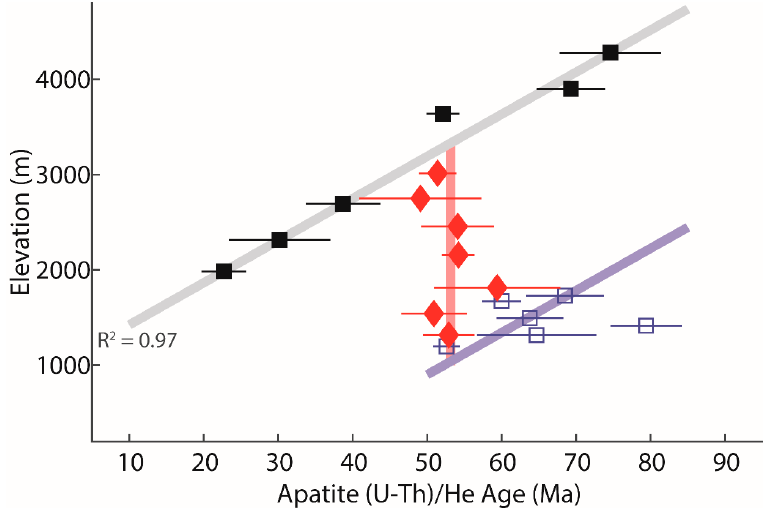
Figure 3. Apatite (U-Th)/He age versus elevation for the three sample suites of the composite transect across Owens Valley, with two sigma errors plotted. Black solid squares and grey line: [9] data and linear regression. Red diamonds with red line: [11] data with a vertical line plotted at the average age. Blue open squares with blue line: [10] data from the Alabama Hills with slope of the southern Sierra Nevada regional exhumation rate, which is the same as the regressed value shown here as a grey line through black squares.